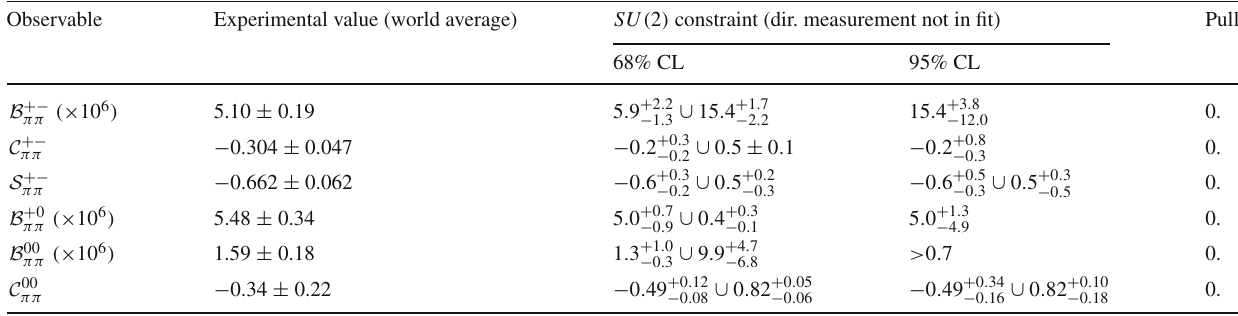
Table 14 Indirect SU ( 2 ) isospin determination of B → ππ observables compared to their experimental measurement Observable Experimental value (world average)